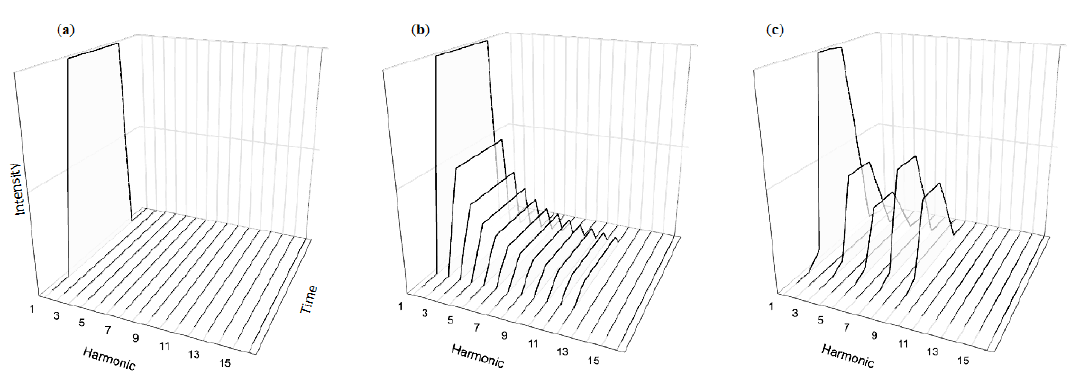
Figure 3. The temporal simplicity of most pure tones (a) as well as harmonically rich sawtooth tones (b) used in auditory research is similar to those found in industry standard alarm tones (c).